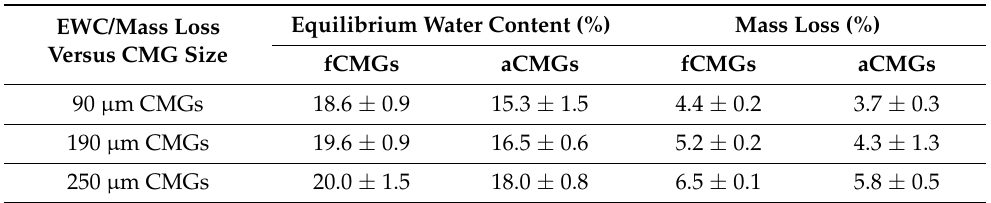
Table 1. Equilibrium water content and mass loss of fCMGs and aCMGs for CMG average sizes of 90, 190, and 250 µ m.